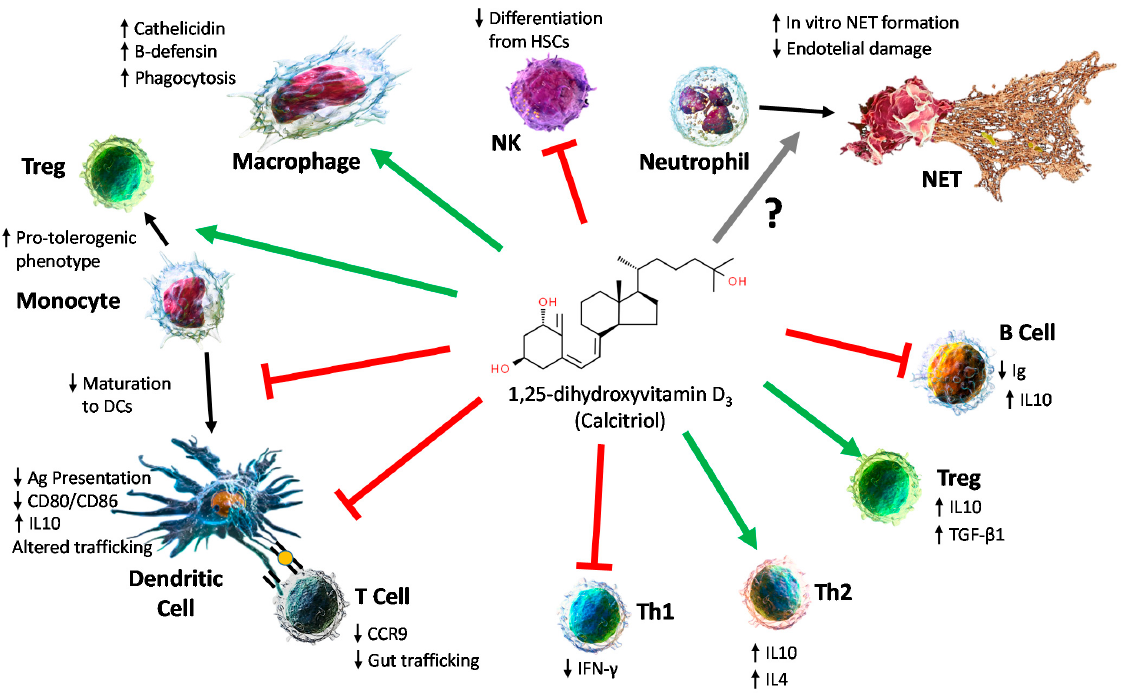
Figure 2. Summary of vitamin D’s effects on immune cells.